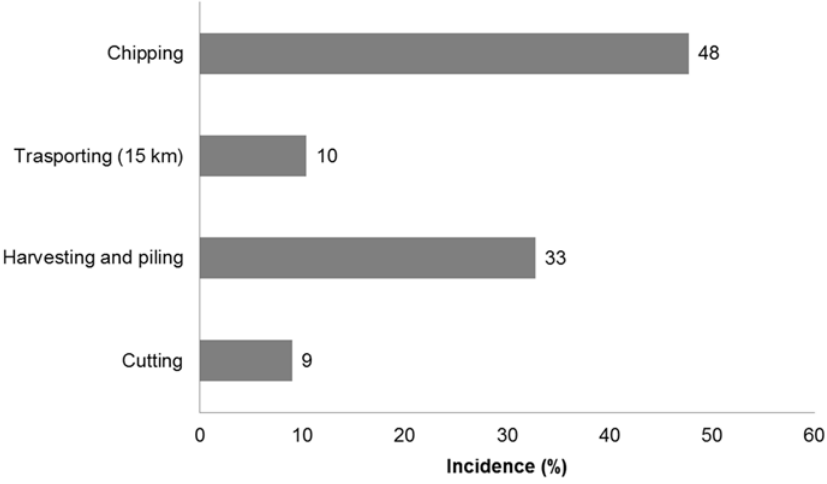
Figure 4. Incidence of the different working operations on the total energy required for woodchip production.